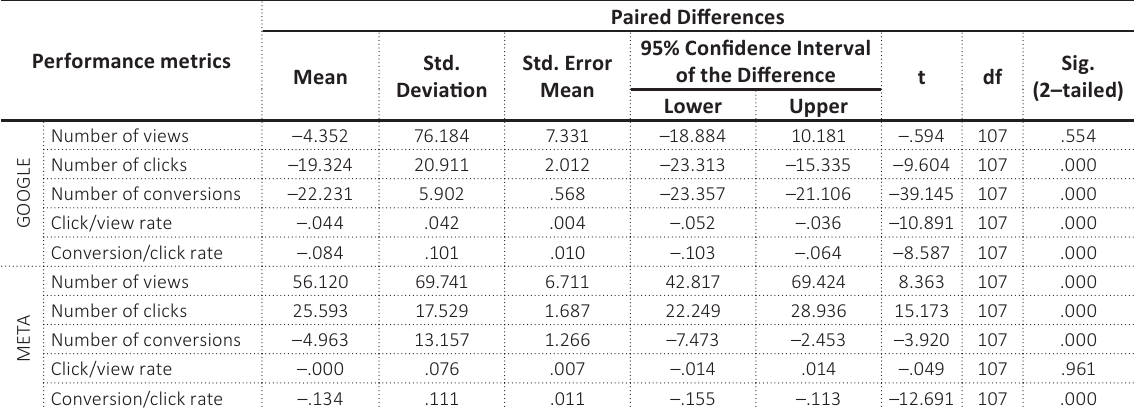
Table 5. Paired samples test: Standard and dynamic Performance